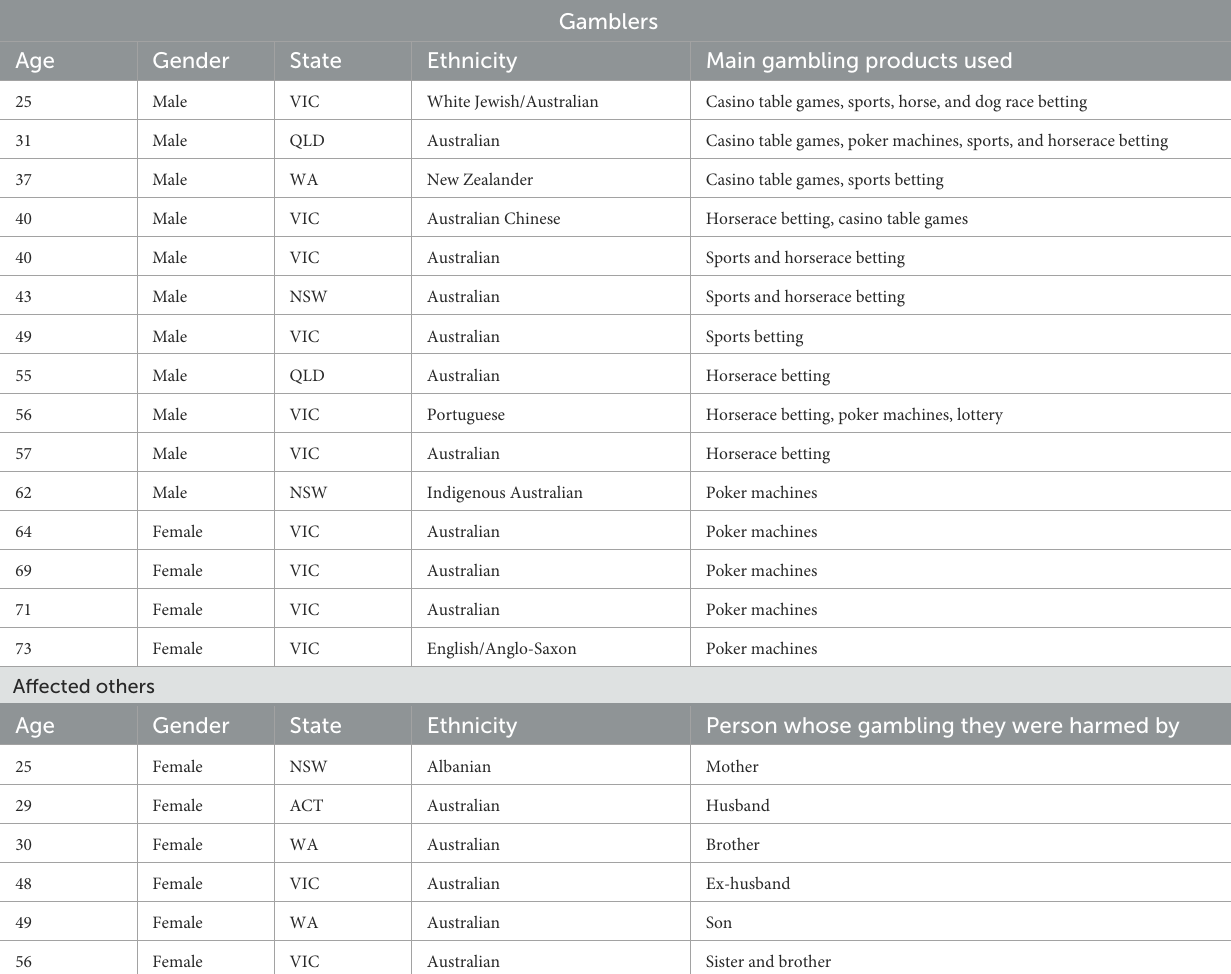
TABLE 1 Participant demographics.